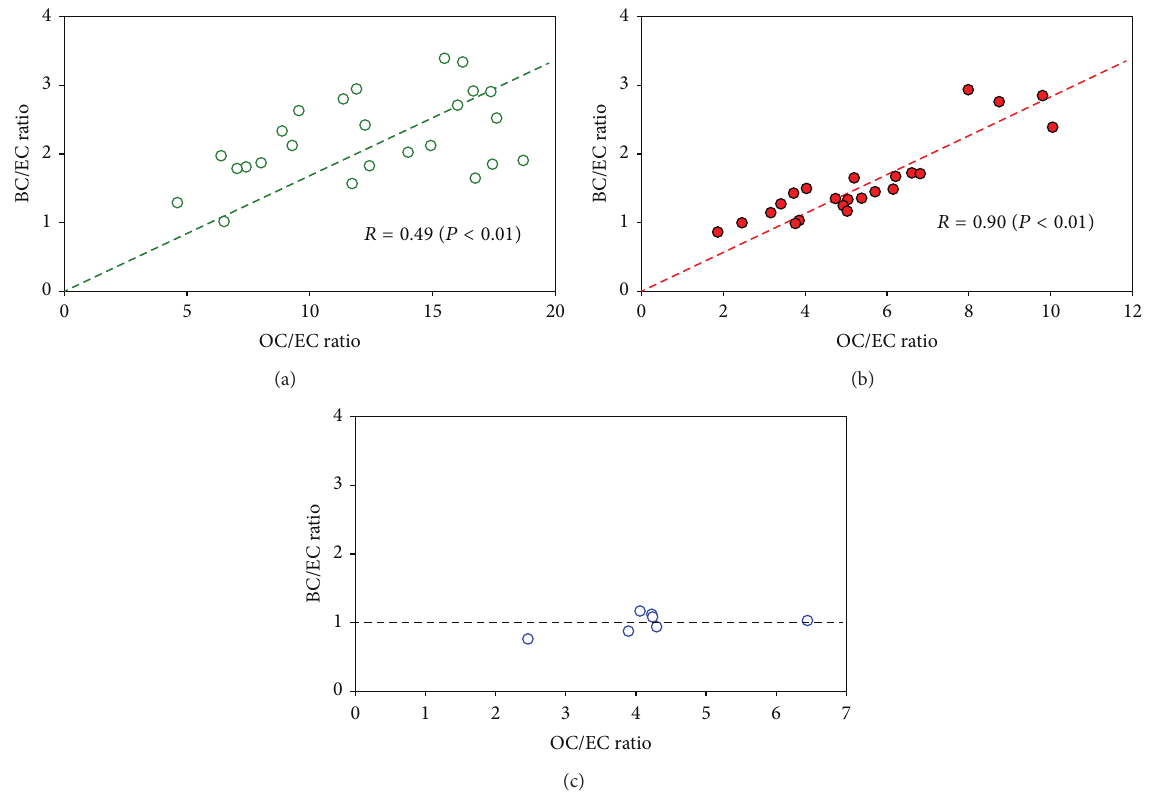
Figure 4: Scatter plots between the BC/EC ratio and OC/EC ratio during: (a) paddy-residue burning emission (October-November); (b) biofuel burning emission and fossil-fuel combustion (December–March); and (c) wheat-residue burning emission